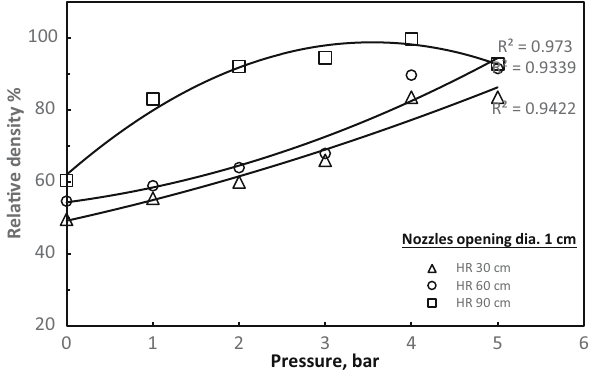
Figure 6: Variation of RD, TAP, and HF for nozzle size of 1.0